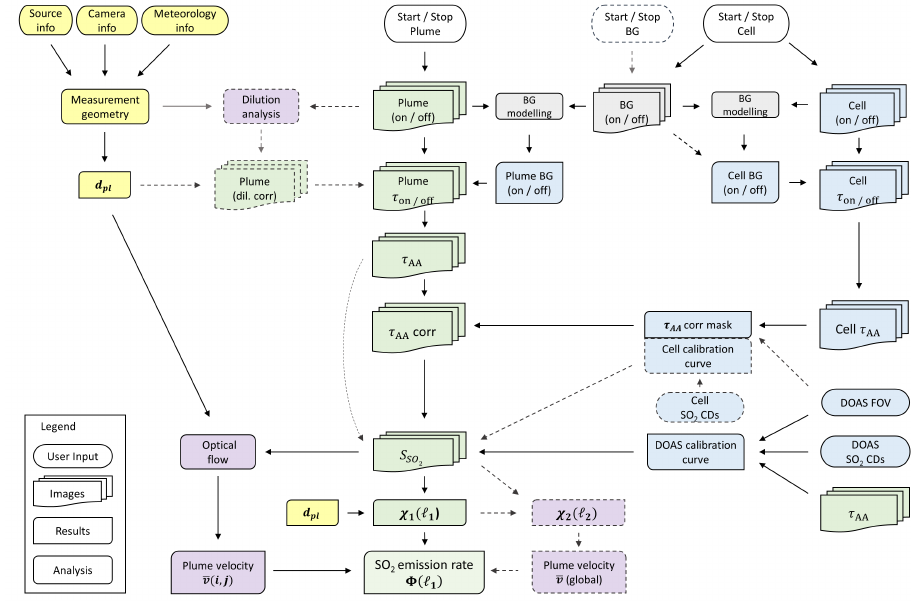
Figure A1. Main analysis steps. Flowchart showing the main analysis steps for emission rate retrievals (cf. Table 1). The colours indicate geometrical calculations (yellow), background modelling (light gray), camera calibration (light blue), plume velocity retrieval (light purple) and the central processing steps for the emission rate retrieval (light green). Shaded and dashed symbols indicate optional or alternative analysis methods. Note that the colour scheme is not related to the scheme used in Figure